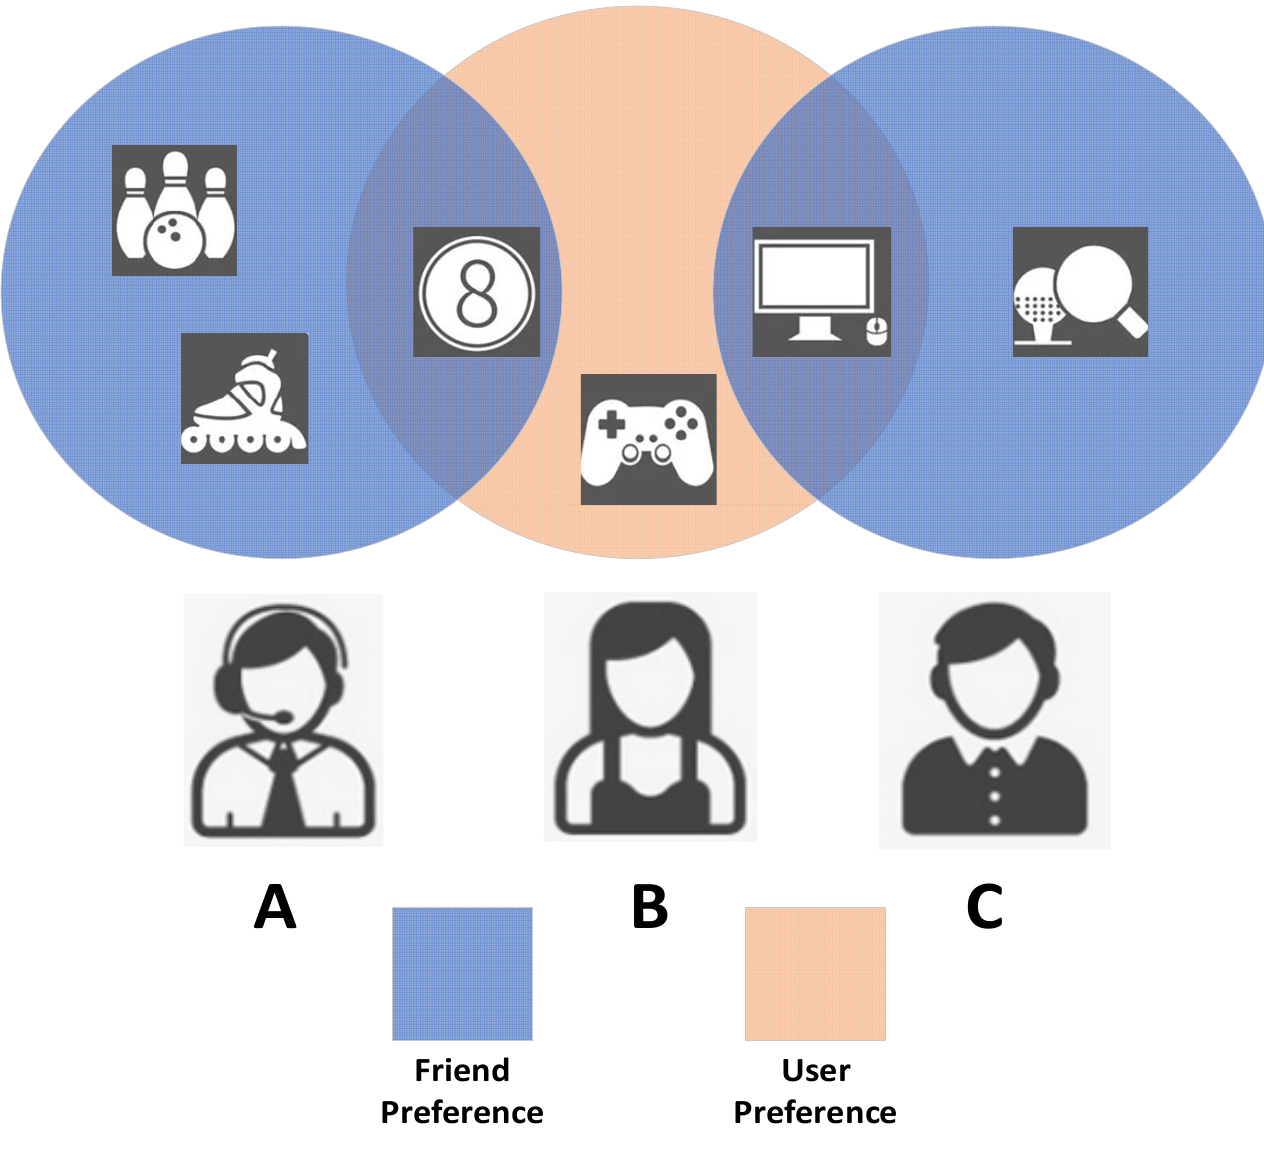
Figure 1. Typical scenario for social recommendation.